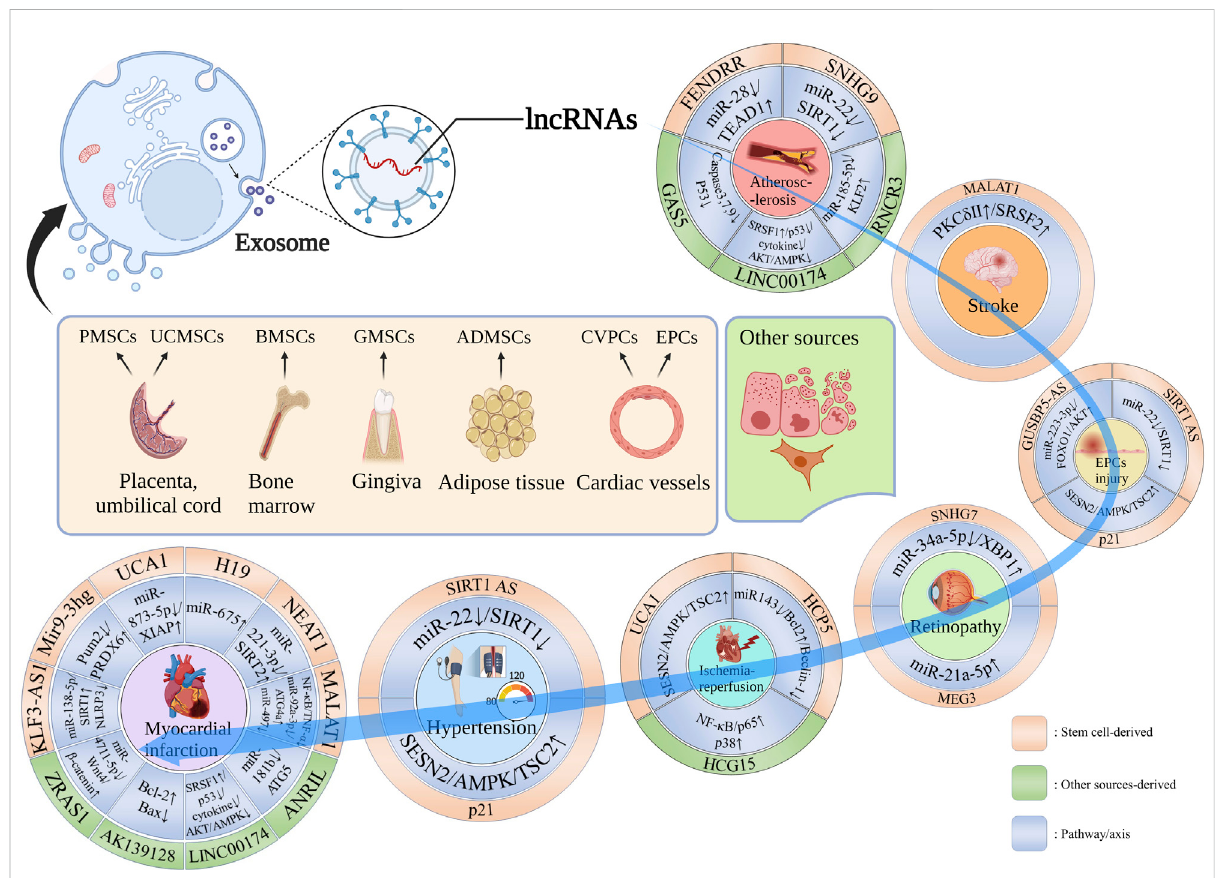
FIGURE 1 Stem cell-derived Exo-lncRNA with diverse organ sources and other sources in the CVDs occurrence and progression. lncRNA-FENDRR, lncRNA-SNHG9, lncRNA-RNCR3, LINC00174 and lncRNA-GAS5 contribute to AS occurrence and progression; lncRNA-MALAT1 promotes nerve repair after stroke; SIRT1 AS lncRNA, lncRNA-p21 and lncRNA GUSBP5-AS are involved in EPC repair, the former two are also promote vascular damage repair caused by hypertension; lncRNA-SNHG7 and lncRNA-MEG3 are involved in retinopathy; lncRNA-UCA1, lncRNA-HCP5